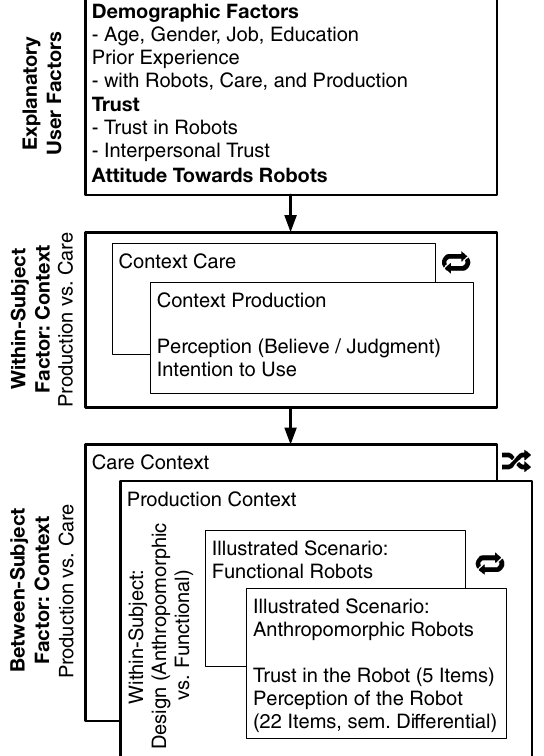
Figure 2: Flow of the survey starting with explanatory user factors, measurement of usage intention and future role of robots ( for care and production ) , and assessment of trust and robot perception for the two contexts and two designs.